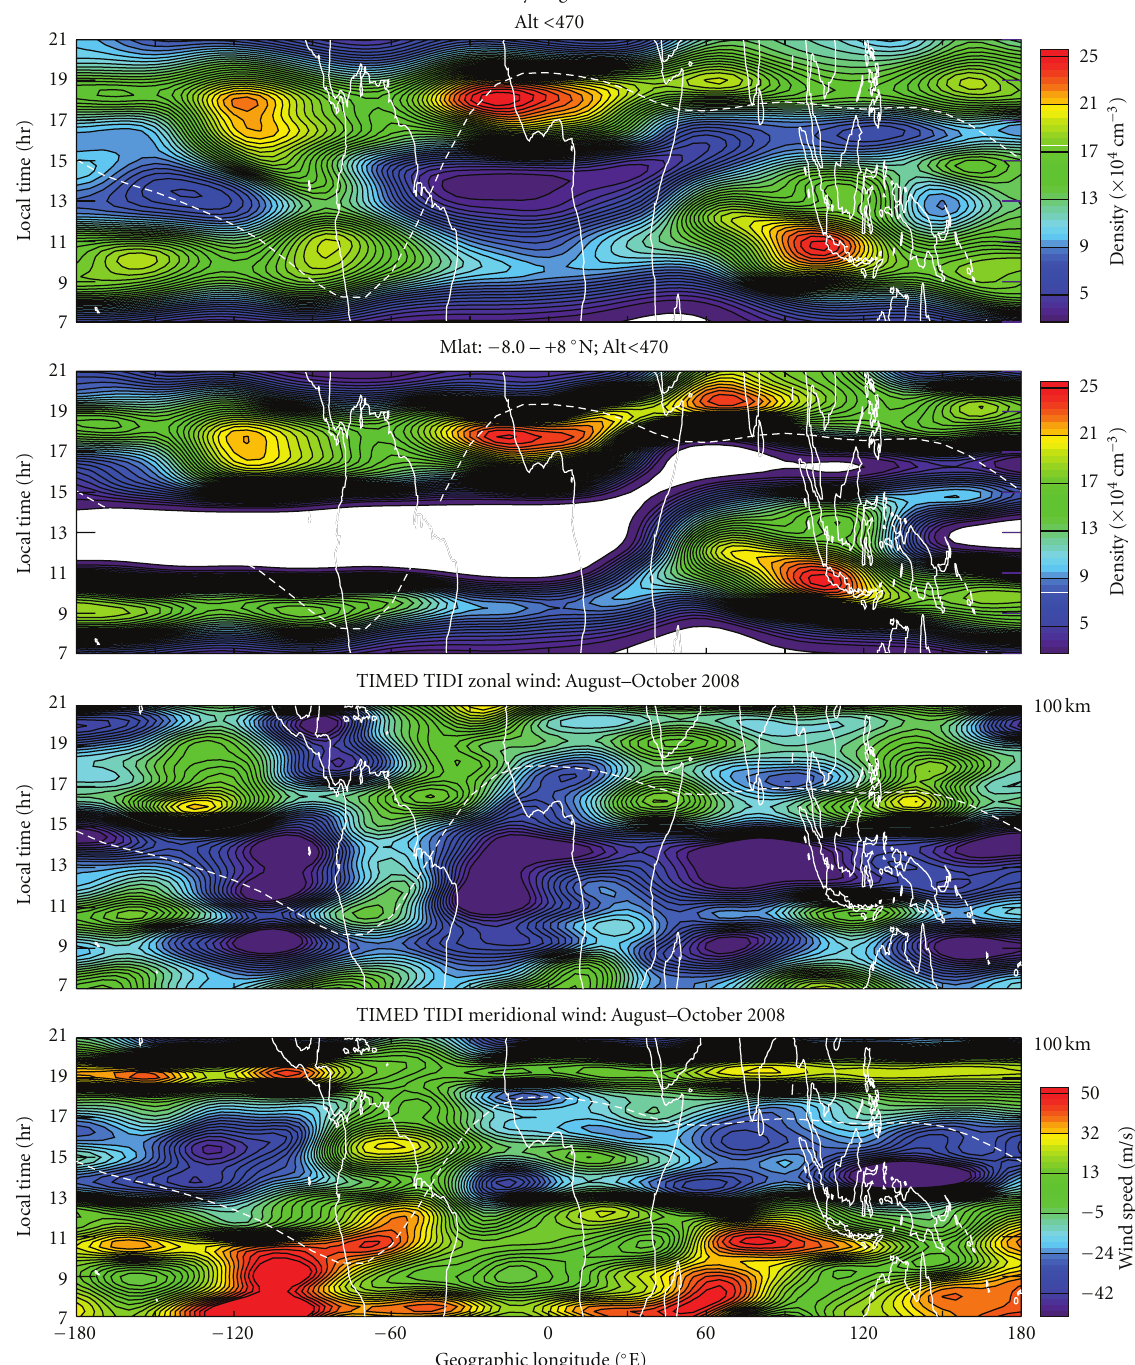
Figure 4: Plot of the statistical 2D (local-time/longitude) ionospheric in situ density observed during quiet days ( K p ≤ 3) by PLP instrument onboard C/NOFS during August–October 2008. The top panel shows the in situ density average when the satellite was below 470 km altitude for the whole latitudes ( ± 13 ◦ N geographic latitude), and for only ± 8 ◦ magnetic latitudes coverage (second from top panel). The bottom two panels show the zonal and meridional wind components observed by TIDI instrument onboard TIMED